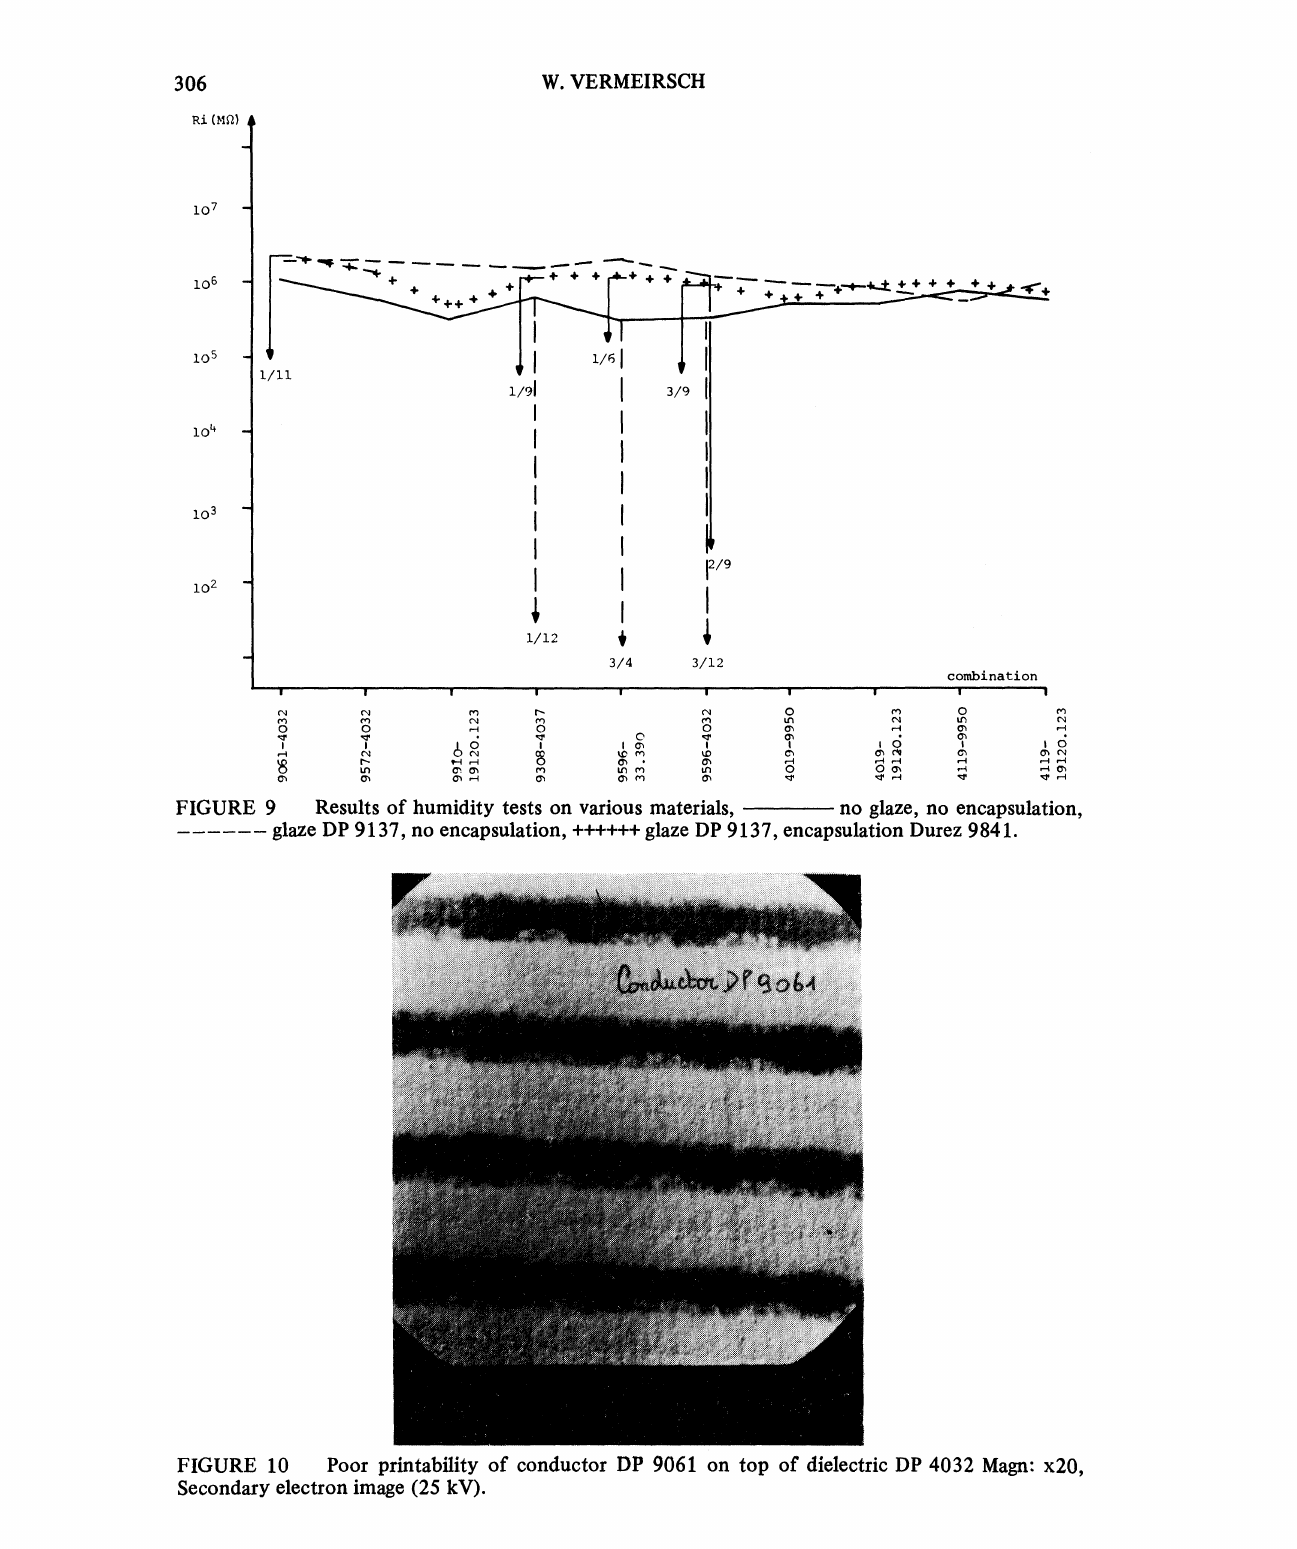
FIGURE 10 Poor printability of conductor DP 9061 on top of dielectric DP 4032 Magn: x20, Secondary electron image (25